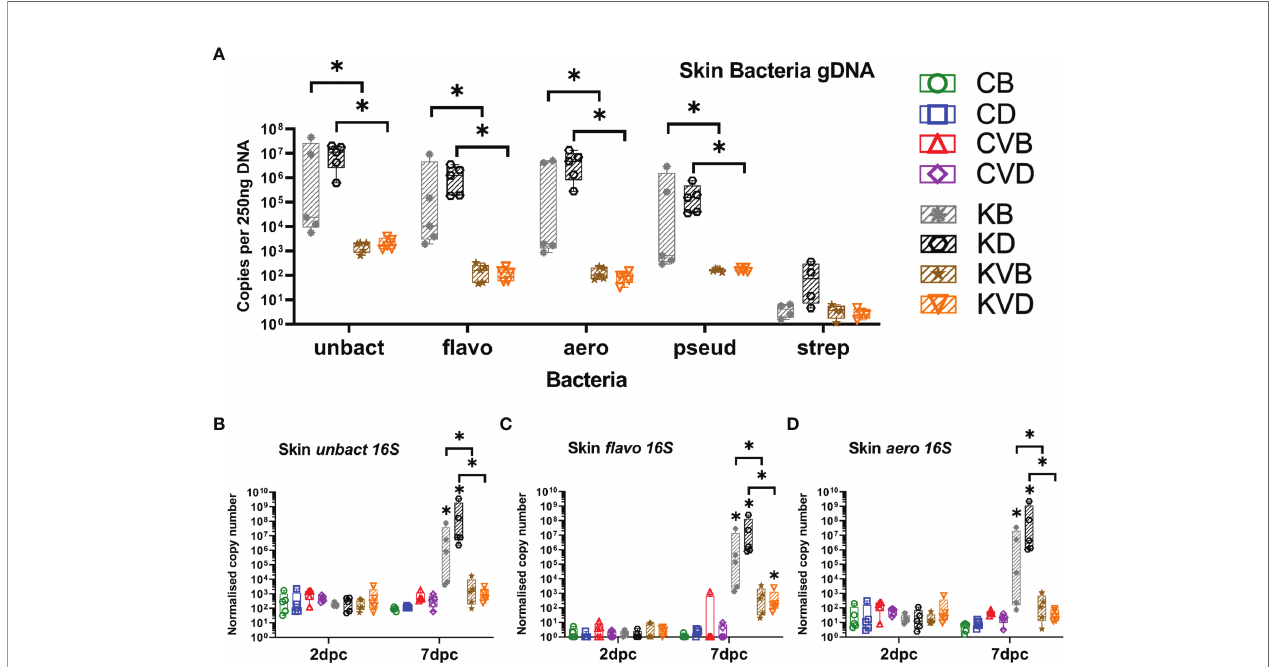
FIGURE 8 | Bacterial load and level of 16S rRNA for selected bacteria species after challenge with CyHV-3 measured with qPCR or RT-qPCR. (A) All bacteria (unbact), fl avobacteria ( fl avo), aeromonads (aero), pseudomonads (pseud) and streptococci (strep) load in skin at 7 dpc. Expression of bacterial 16S rRNA: (B) all bacteria 16S in skin at 2 dpc and 7 dpc, (C) fl avobacteria 16S in skin at 2 dpc and 7 dpc, (D) aeromonas 16S in skin at 2 dpc and 7 dpc. The description of experimental groups: CB – BSA, non-vaccinated, unchallenged control, CD – defensins, non-vaccinated, unchallenged control, CVB – BSA, vaccinated, unchallenged control, CVD – defensins, vaccinated, unchallenged control, KB - BSA non-vaccinated, CyHV-3 challenged, KD – defensins non-vaccinated, CyHV-3 challenged, KVB – BSA, vaccinated, CyHV-3 challenged, KVD – defensins, vaccinated, CyHV-3 challenged. The results are presented as 25%-75% box plots with min. and max. values as whiskers with indication of all data points. Bacteria load data are shown as genomic 16S copy numbers normalised for 250 ng of extracted DNA. The expression data are shown as normalised copy numbers. * indicates statistical signi fi cant difference at p < 0.05. Statistical analysis was performed with two-way ANOVA with multiple comparisons test performed with the Holm-Sidak